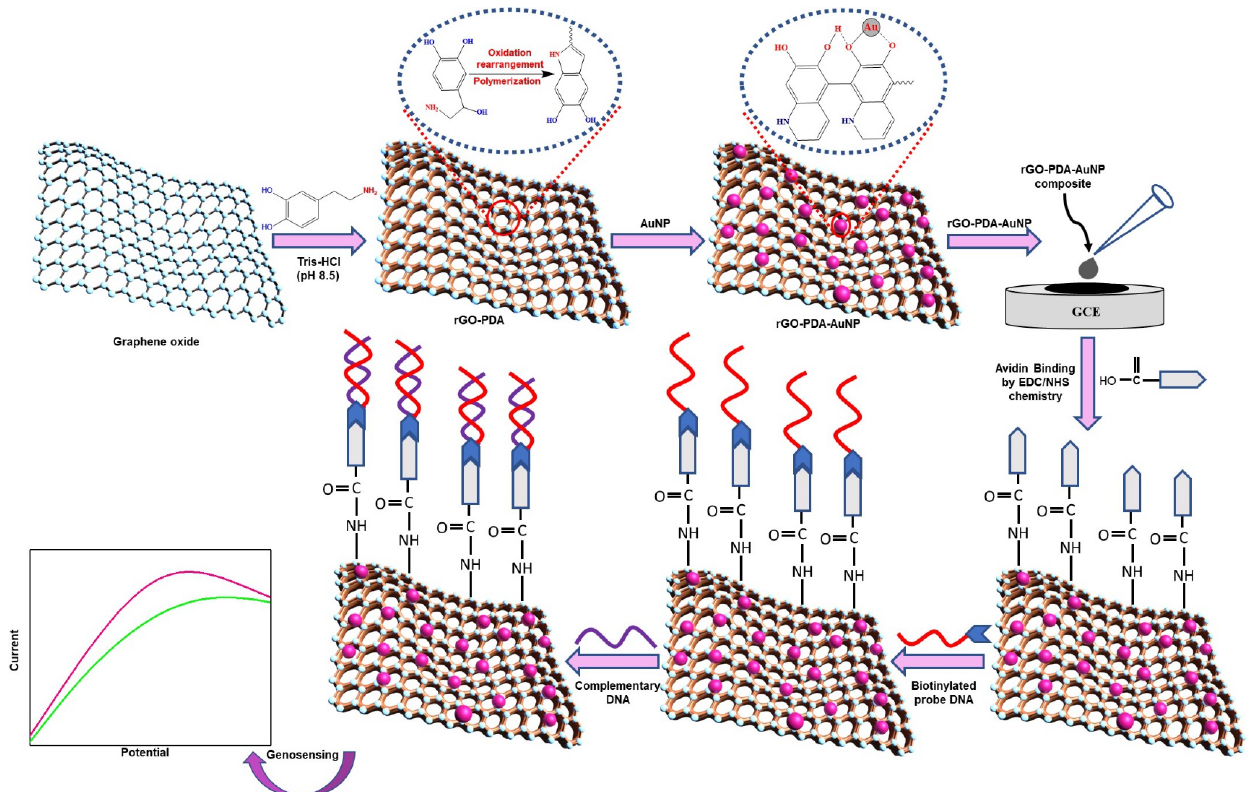
Figure 1. This is a figure. Schemes follow the same formatting. If there are multiple panels, they should be listed as: ( a ) Description of what is contained in the first panel. ( b ) Description of what is contained in the second panel. Figures should be placed in the main text near to the first time they are cited. A caption on a single line should be